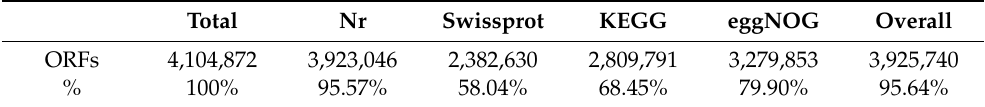
Table 3. Summary of functional annotation results.